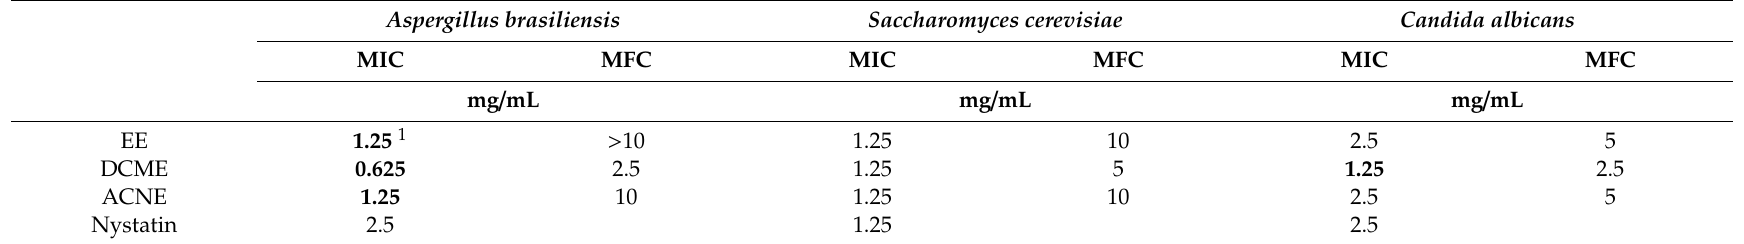
Table 5. Antifungal activity of H. plicatum ethanol (EE), dichloromethane (DCME), and acetonitrile oil (ACNE)